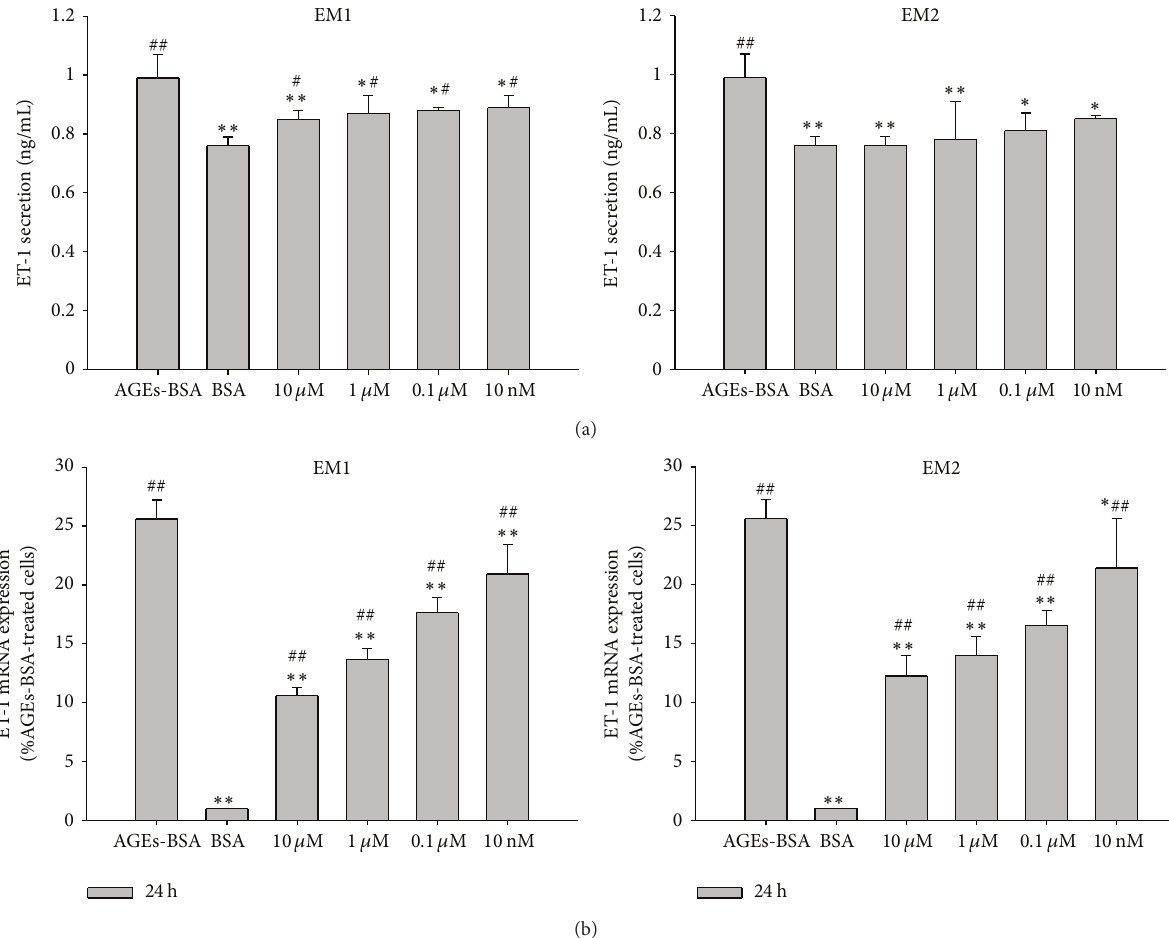
Figure 6: Effect of EM1, EM2 on ET-1 secretion determined by ELISA test in HUVEC (a). HUVECs were incubated according to the aforementioned grouping. Each value represents the mean ± SD ( 𝑛 = 3 ); mRNA expression level of ET-1 after treatment with AGEs-BSA and EM1 or EM2, using BSA treated cells as reference control (b). The parameter Ct was derived for each cDNA sample and primer pair; for a given sample, Ct values for 𝛽 -actin were subtracted from the Ct of each candidate gene reaction to arrive at a Δ Ct value. The mean Δ Ct from all control reactions was then subtracted from the Δ Ct of each treated sample to arrive at ΔΔ Ct. The relative fold change was calculated by the expression 2 −ΔΔ Ct . Each data is expressed as mean ± SD ( 𝑛 = 3 ). ∗ 𝑃 < 0.05, ∗∗ 𝑃 < 0.005 versus AGEs-BSA group, # 𝑃 < 0.05, ## 𝑃 < 0.005 versus control (BSA)